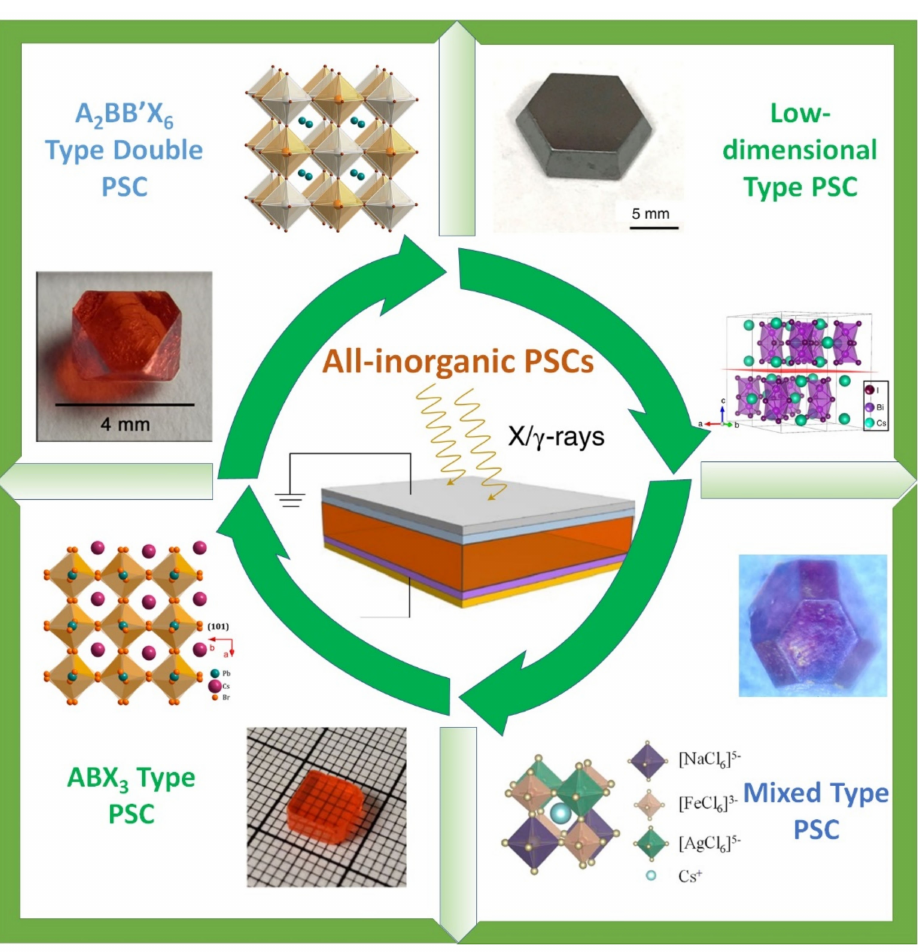
Figure 1. Classification of all-inorganic PSC: AB I B III X 6 type, low-dimensional type, mixed type, and ABX 3 traditional type